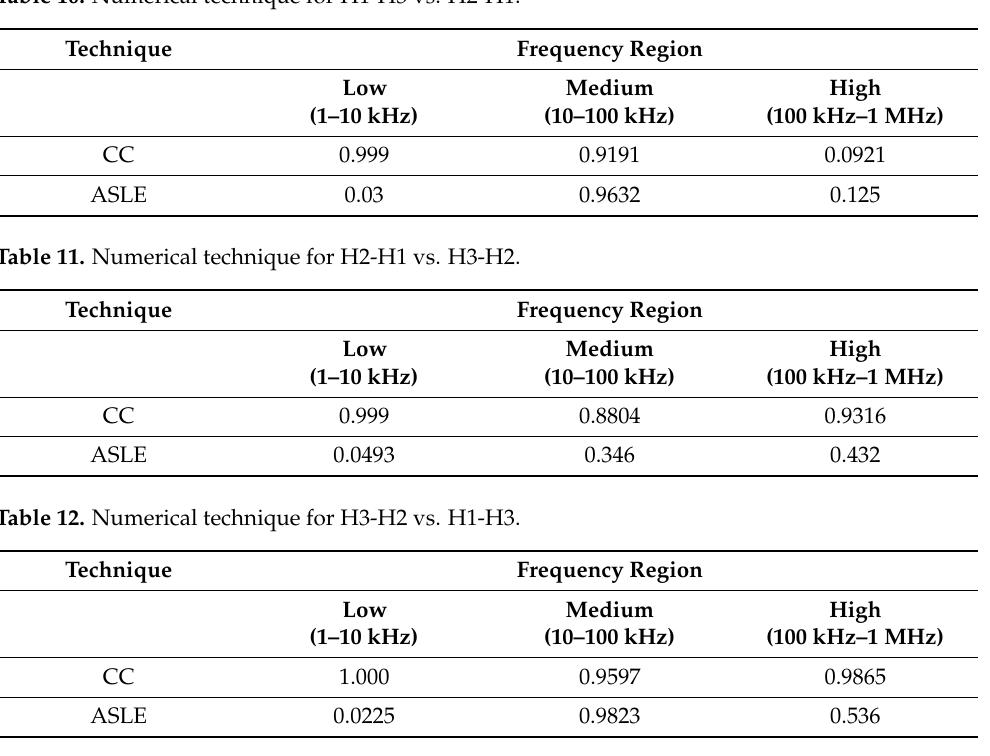
Table 10. Numerical technique for H1-H3 vs. H2-H1.